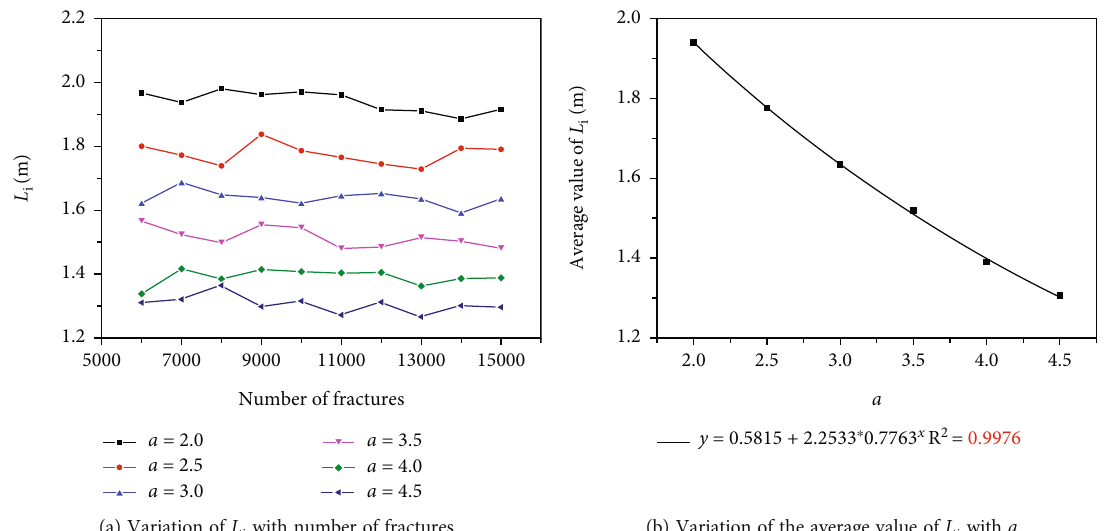
Figure 4: Variation of L